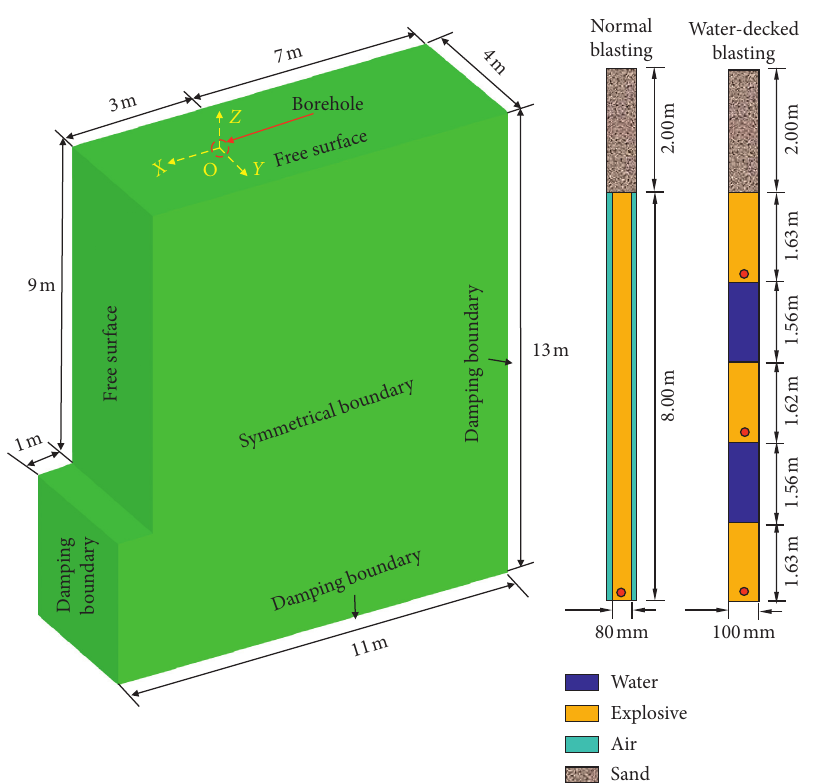
Figure 3: Numerical model of different charge patterns.